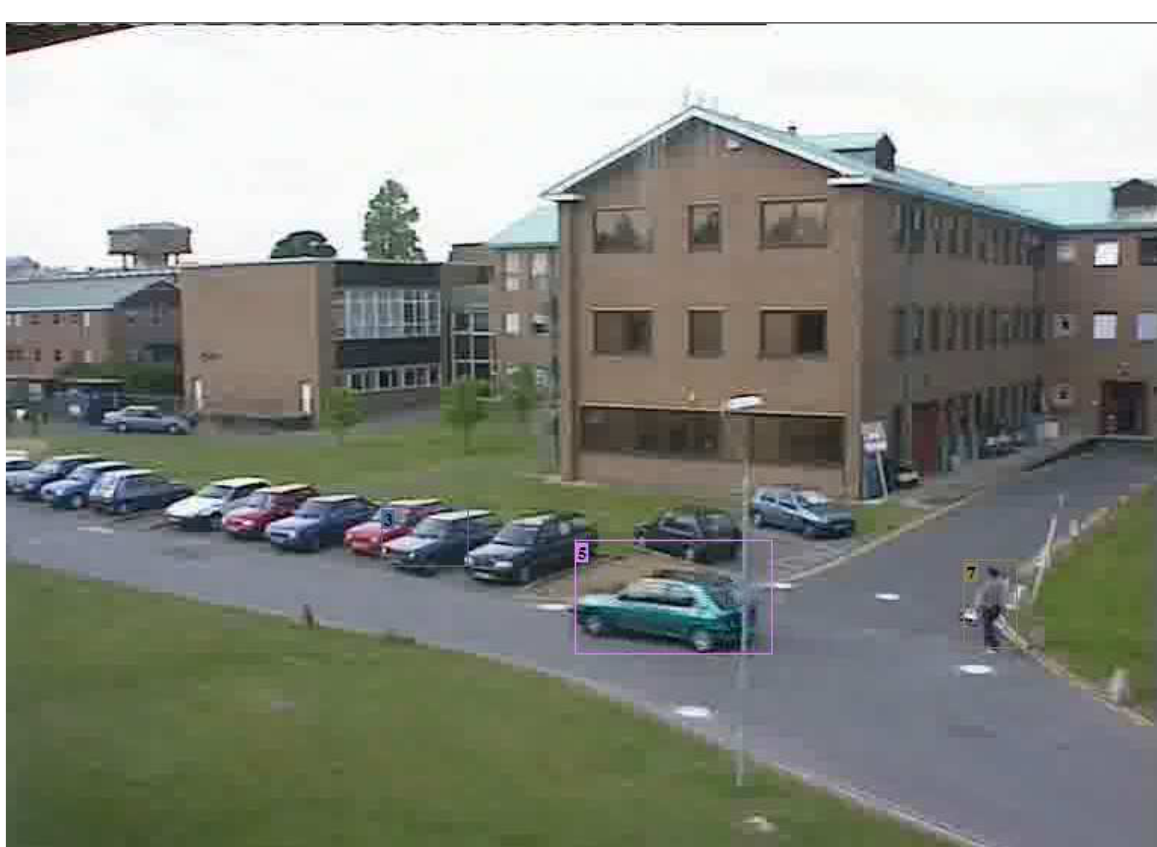
Figure 4: Sample frame of PETS-2001-SEQ1-CAM1 video sequence. Objects, tracked on this frame: walking man (7), moving car (5) and parking car